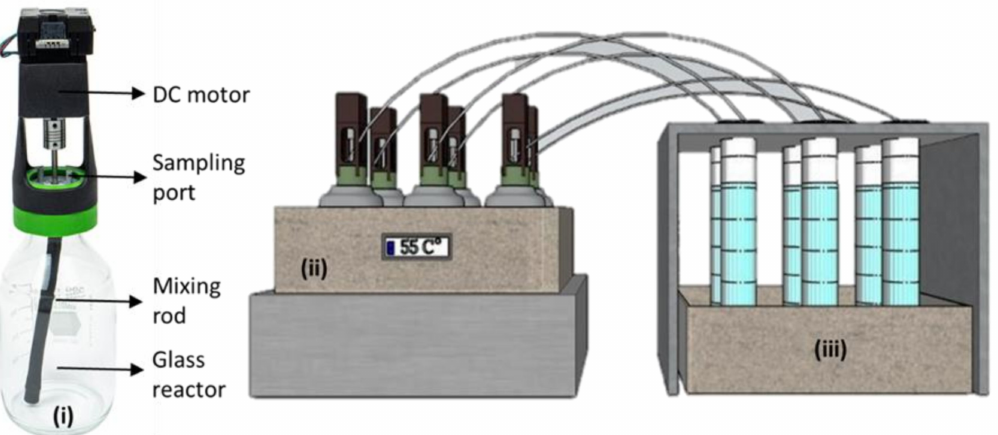
Figure 1. Experimental setup: ( i ) One anaerobic reactor with agitator, sampling and gas collection ports; ( ii ) Bioreactors submerged in a water bath; ( iii ) Water displacement cylinders for biogas collection and